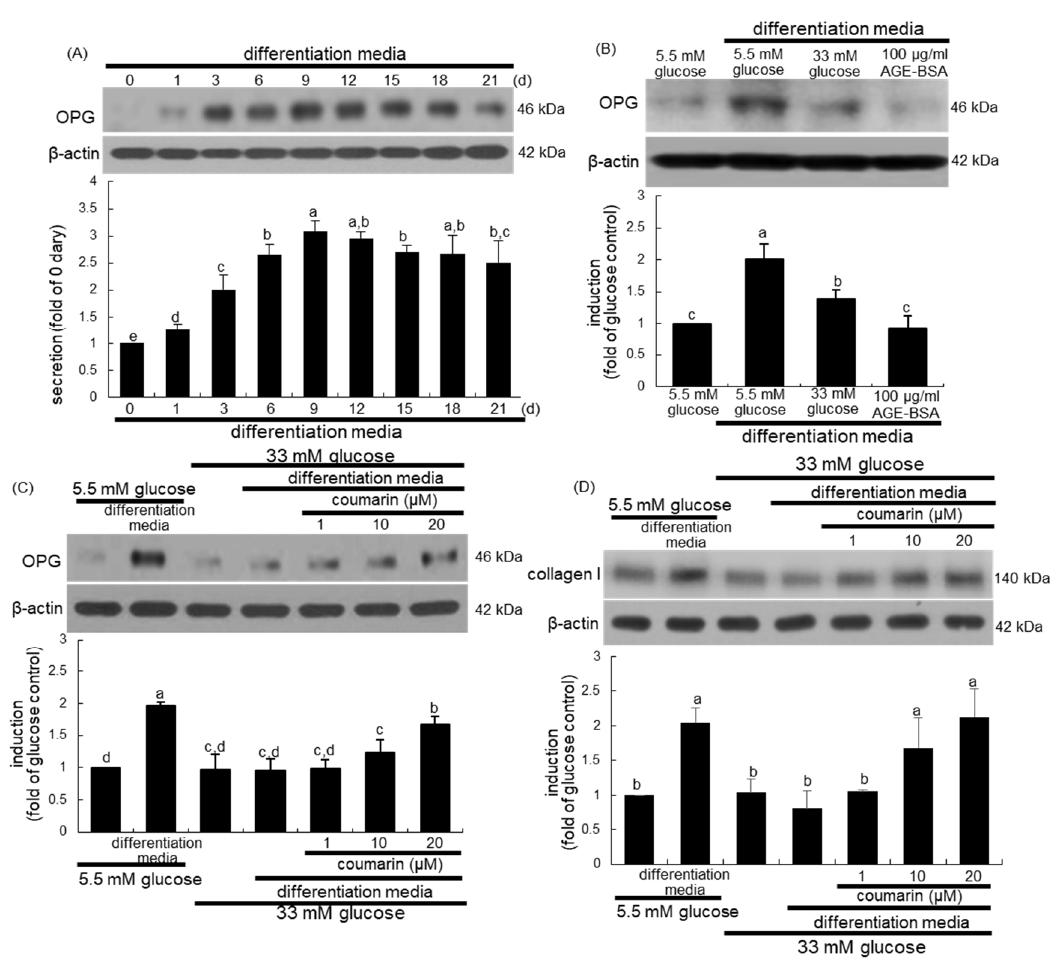
Figure 6. Temporal induction of osteoprotegerin (OPG, A ), and elevation of induction of OPG ( B , C ) and collagen type I ( D ) by coumarin in osteoblastic MC3T3-E1 cells. MC3T3-E1 cells were cultured in differentiation media containing 5.5 mM glucose, 33 mM glucose, or 100 μ g/mL AGE–BSA in the presence of 1–20 μ M coumarin for up to 21 days. Cell lysates were subject to western blot analysis with a primary antibody against OPG and collagen I. Representative blot data were obtained from three independent experiments, and β‐ actin protein was used as an internal control. The bar graphs